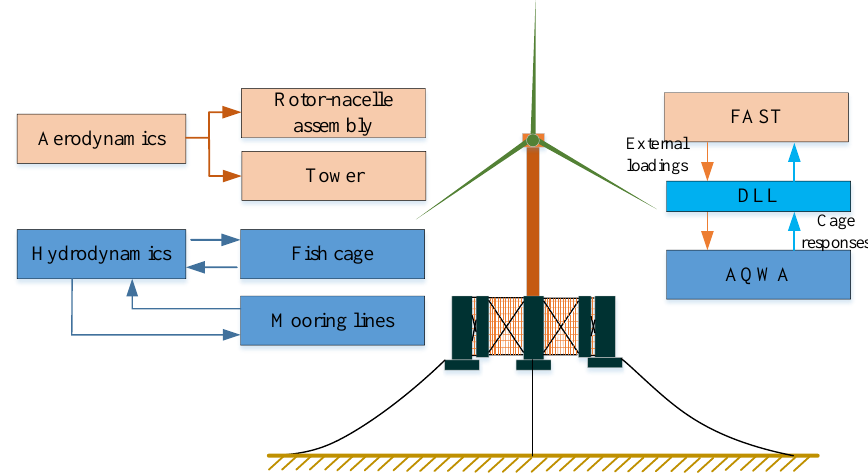
Figure 6. Modeling overview through FAST and AQWA.